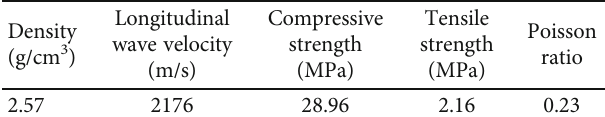
Figure 6: The XRD spectra of mudstone. Table 2: Static mechanical properties of